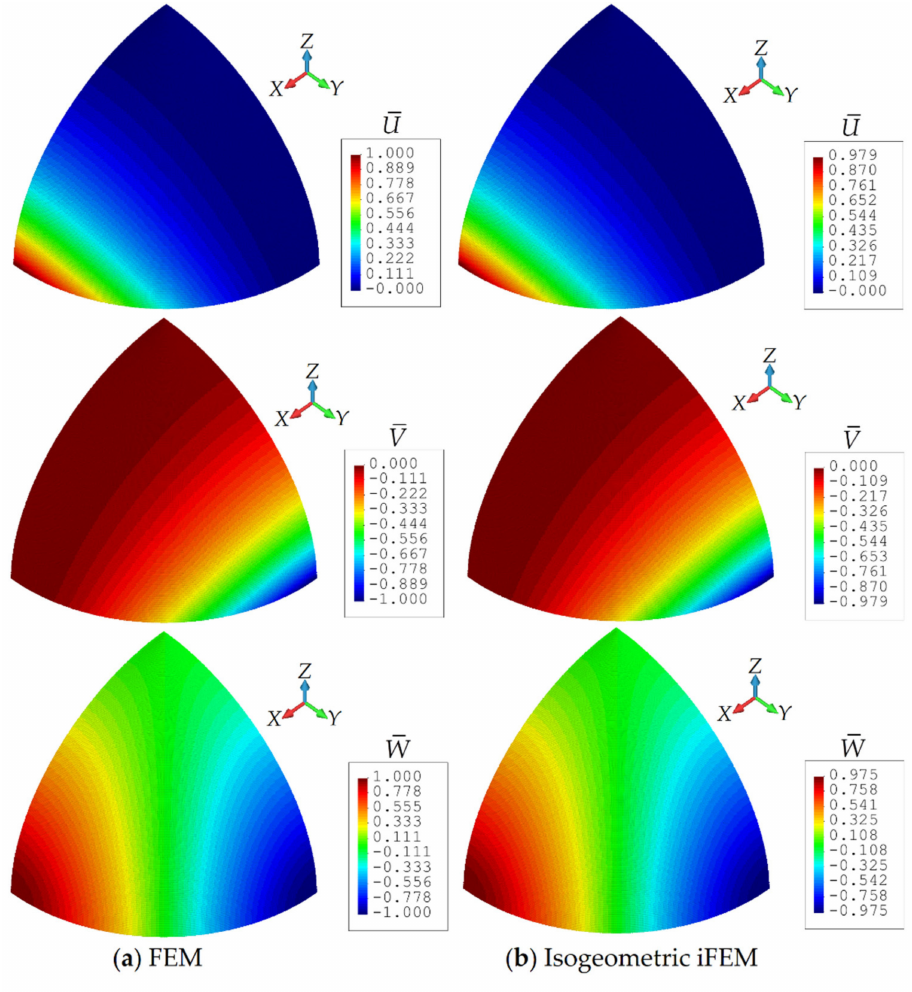
Figure 12. Contour plots of U , V , W displacements for hemisphere: Comparison between ( a ) high-fidelity FEM and ( b ) isogeometric iFEM (n e = 6)